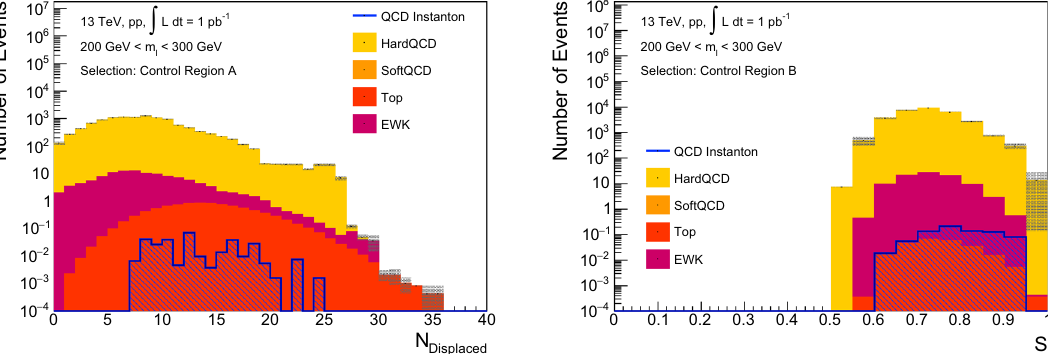
Fig. 16 Predicted distributions of the number of displaced tracks in the control region A (left) and the event sphericity in control region B (right),weightedbytheirpredictedcrosssectionsforanintegratedlumi- (cid:8) nosity of L = 1pb − 1 . The invariant mass of all reconstructed tracks